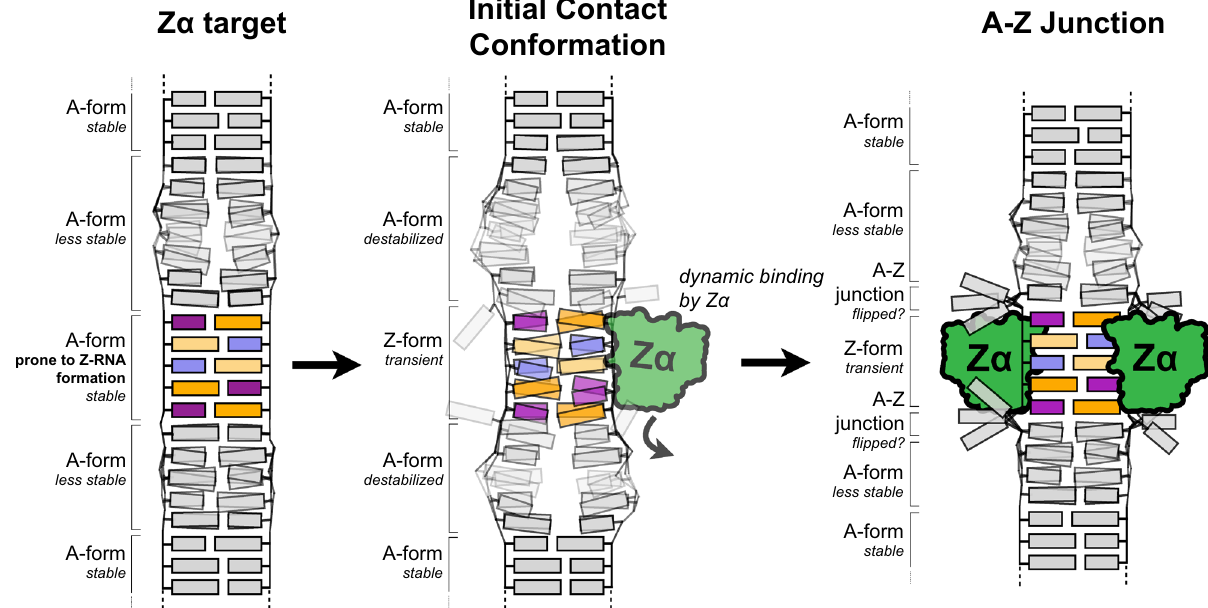
Fig. 8 Model of the sequence speci fi city of Z α . Cartoon model depicting the proposed sequence speci fi city of Z α . A Z-RNA-prone region of dsRNA is fl anked by regions of less stable A-form RNA (left). First, Z α dynamically interacts with the Z-prone sequence (usually comprising YpR steps and non- Watson – Crick pairs) in the initial contact conformation, which begins to convert the region to the Z-conformation, while also destabilizing the neighboring A-form regions (middle). This promotes the binding of another Z α molecule which then stabilizes the Z-conformation and converts the RNA into an A-Z junction (right), which may contain fl ipped out base pairs as has been seen for B-Z junctions 34